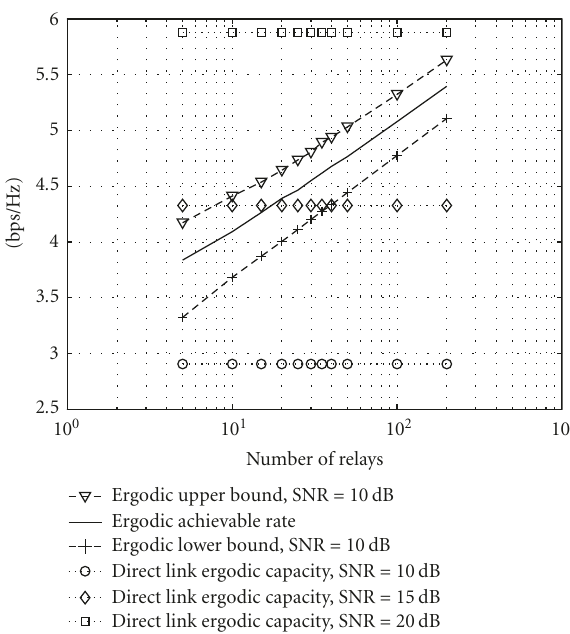
Figure 4: Ergodic achievable rate in [bps/Hz] of a Gaussian multi- ple relay channel with transmit SNR = 10 dB, under Rayleigh fad- ing. The upper and lower bounds proposed in the paper are shown, and the ergodic capacity of a direct link plotted as